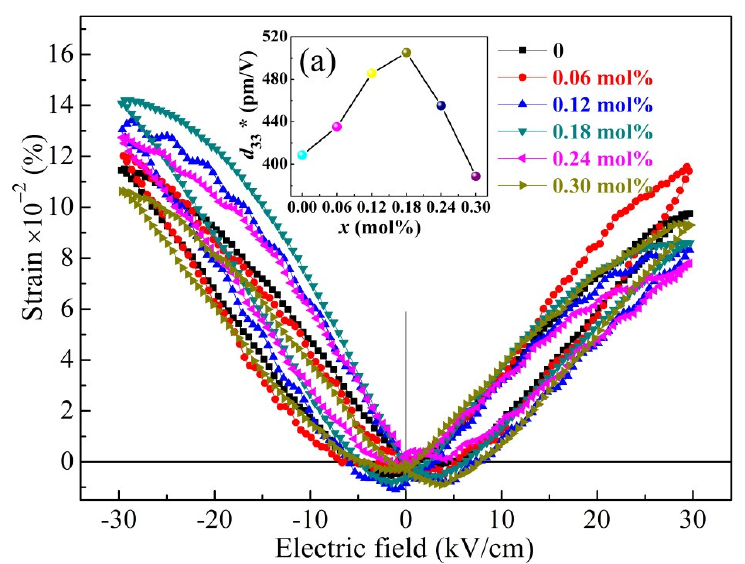
Figure 8. The loops of strain–electric field ( S-E ) of the BCTZ-NY x ceramics; the inset ( a ) shows the piezoelectric coefficients ( d 33 *).